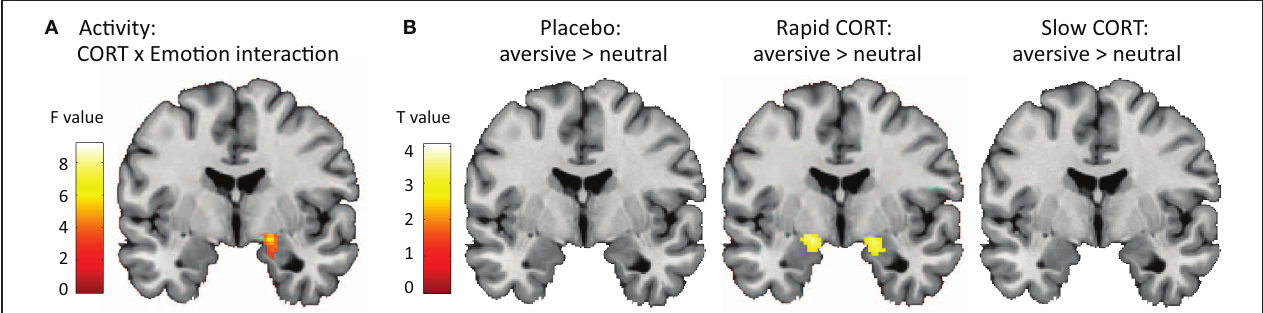
FIGURE 2 | Effects of corticosteroids on amygdala activity. (A) Hydrocortisone administration induced trend of a corticosteroid x emotion interaction in the amygdala ( y = − 4). For visualization purposes the statistical parametric map is thresholded at p < 0 . 05 uncorrected with a minimal cluster-size of 250 voxels. (B) This interaction appeared to be driven by a significant effect of emotion in the amygdala due to the rapid